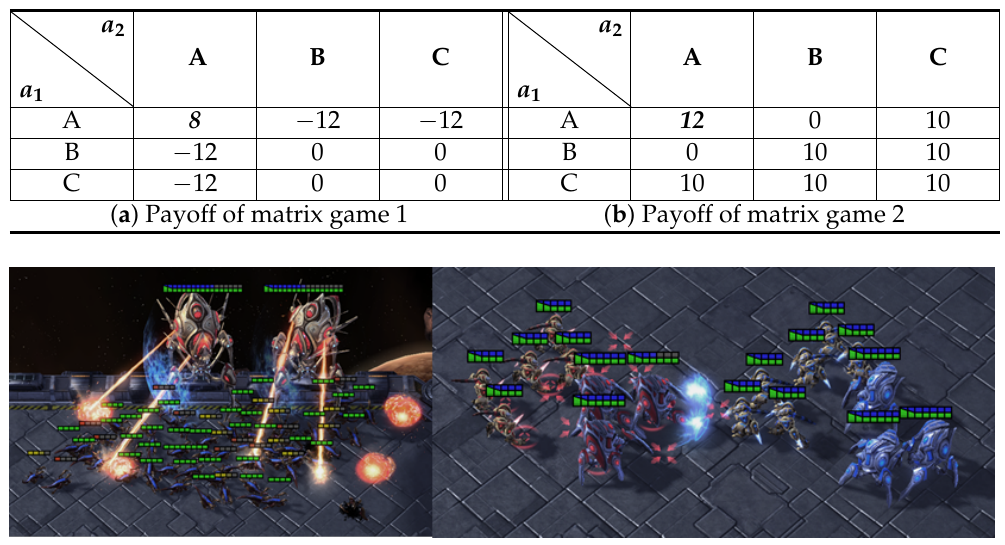
Figure 3. Two typical cooperative scenarios in SMAC: 2c_vs_64zg &